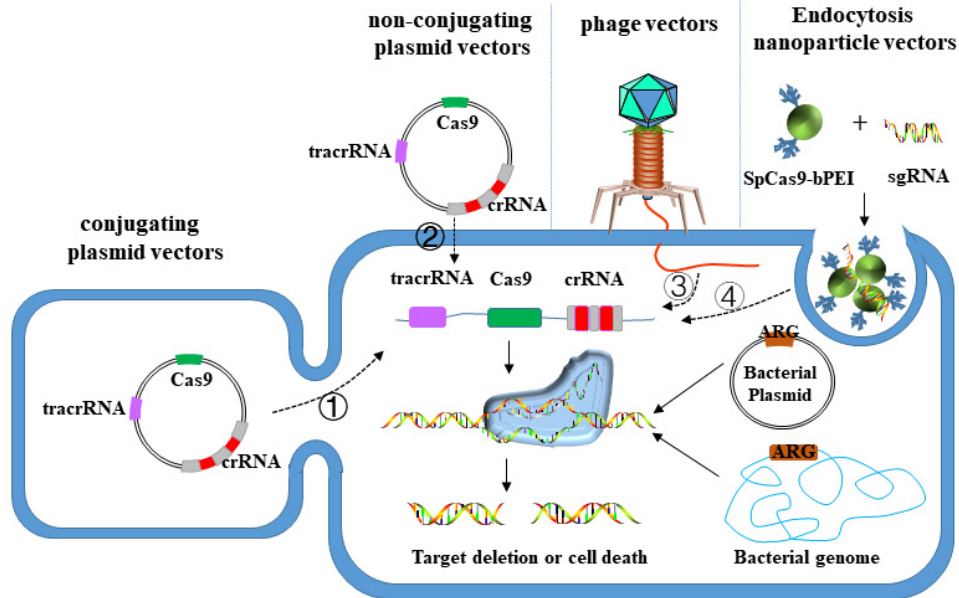
Figure 3. Schematic diagram of CRISPER-Cas editing bacterial drug resistance genes using three different vectors: (1) plasmid vector (conjugated transfer); (2) plasmid vector (non-conjugative transfer); (3) Phage vector; (4) Nanoparticle vector; different vector-mediated sequences have the same action process in bacterial cells.